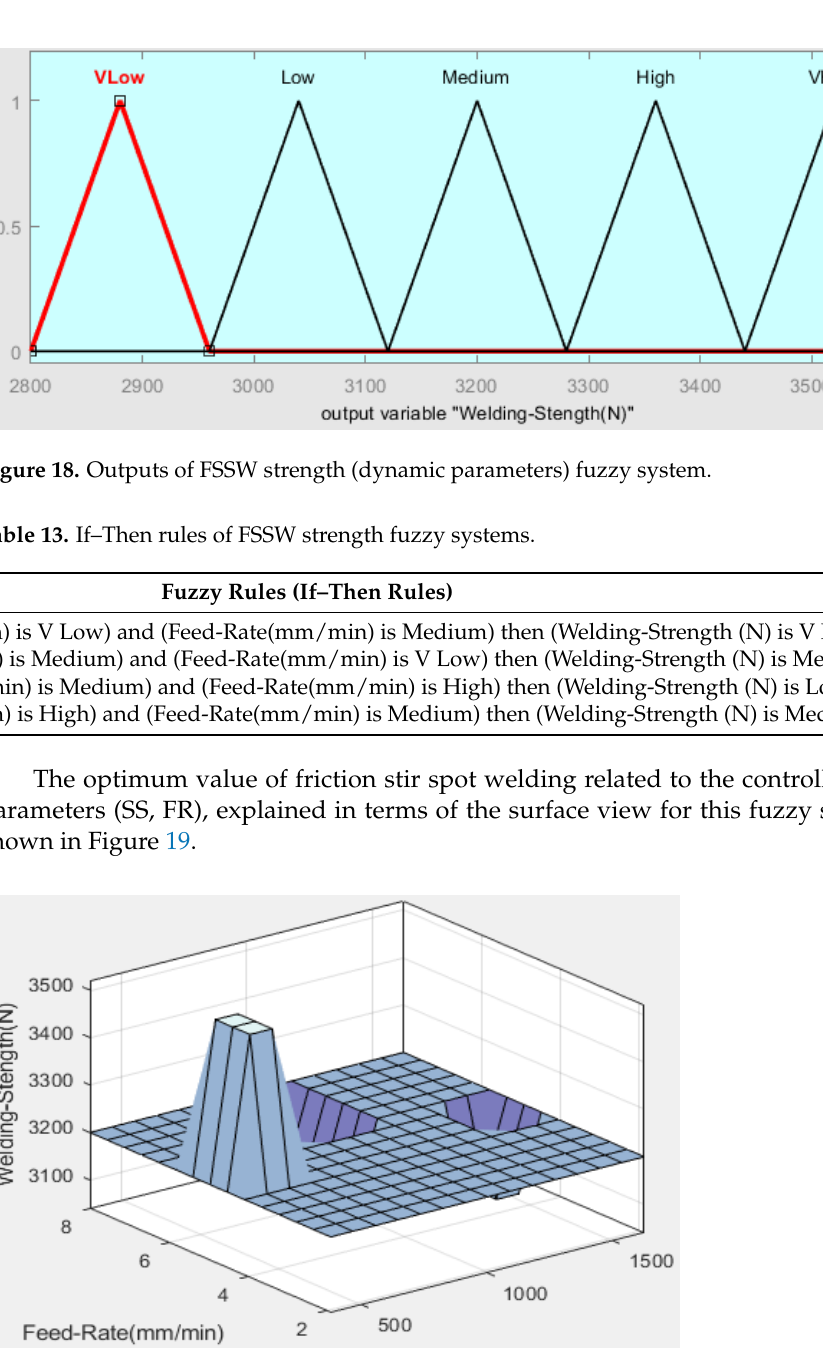
Figure 19. Welding strength variation with spindle speed and feed rate.